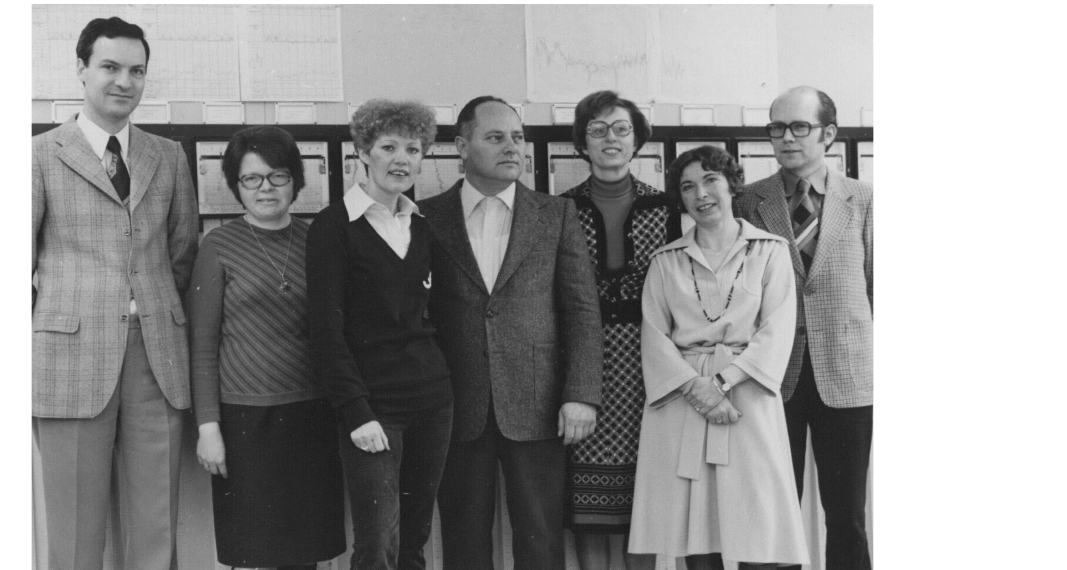
Figure 3. RWC Darmstadt in 1978: from left, Thomas Damboldt, Helga Landvogt, Doris Sperlich, Wilfried Foeks, Ingrid Hohmann, Liddy Schwarz, and Peter